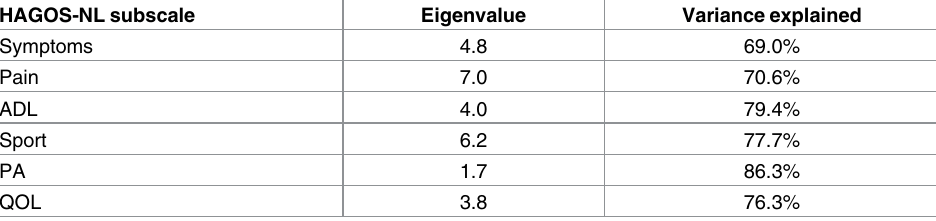
Table 3. Structural validity measuresof the HAGOS-NL.